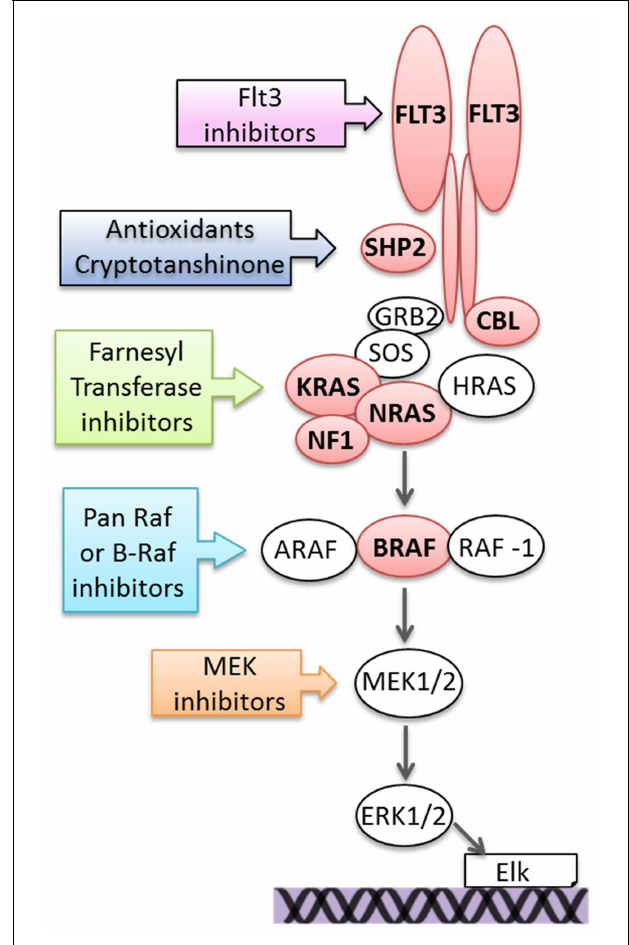
FIGURE 2 | Mutations activating the Ras pathway inALL and potential therapeutic targeting . Components of the pathway that are mutated in ALL are in